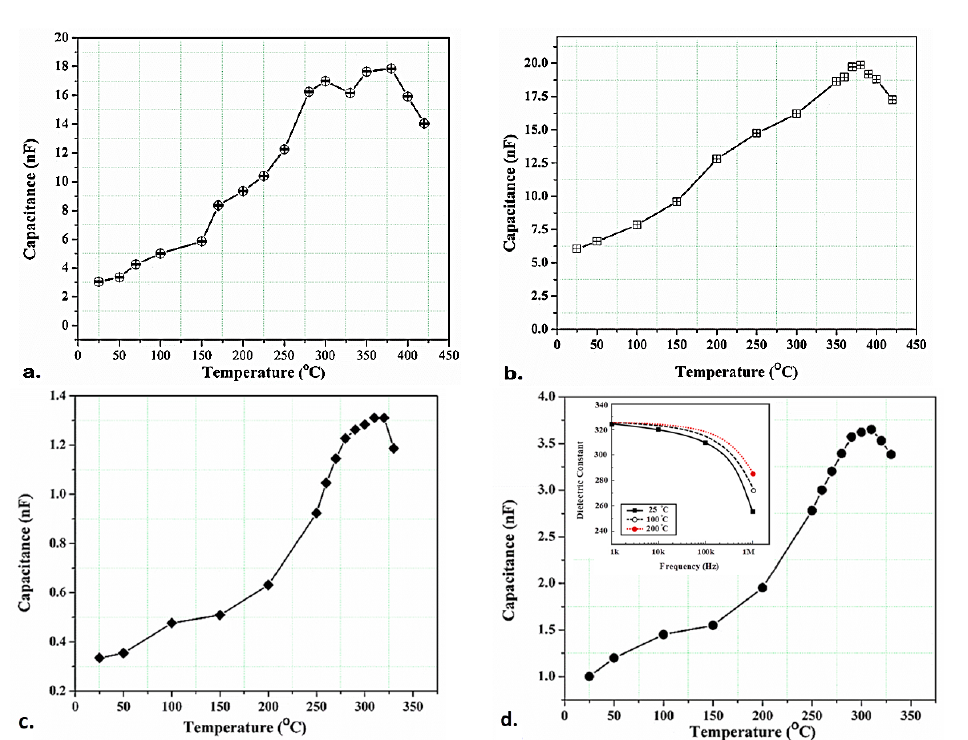
Figure 9. Capacitance variation for: ( a ) PZT/BiT on L 1 (location A), ( b ) PZT/BiT on L 1 (location B), ( c ) PZT/PZT on L 3 (location A), and ( d ) PZT/PZT on L 3 (location B).